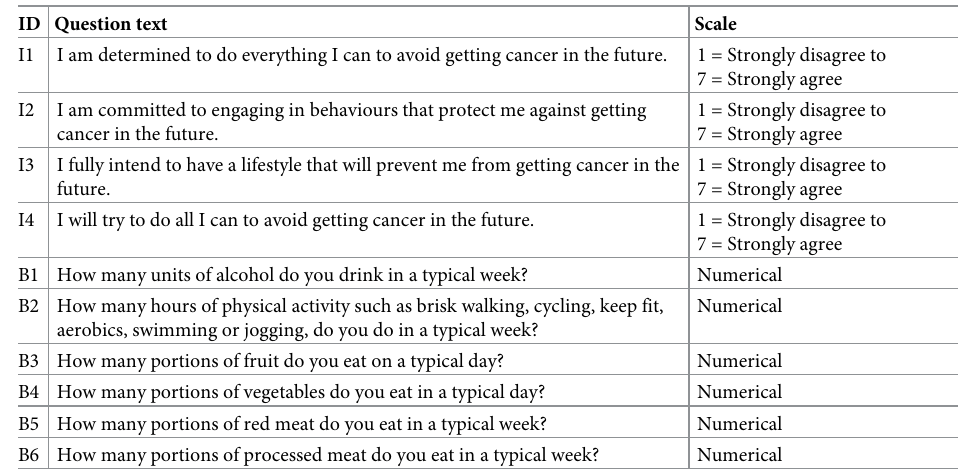
Table 7. Measures of intention and behaviour.